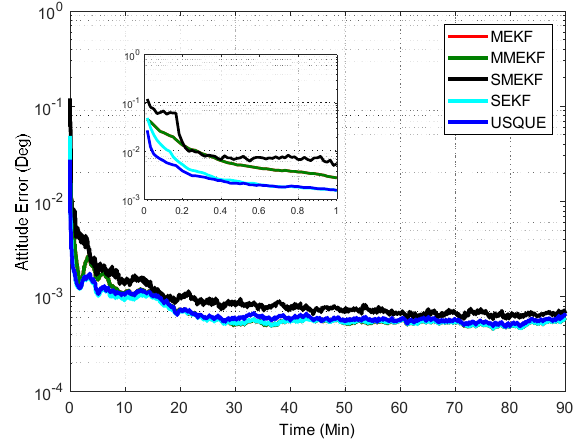
Figure 2. Norm of attitude estimation errors (case 1).